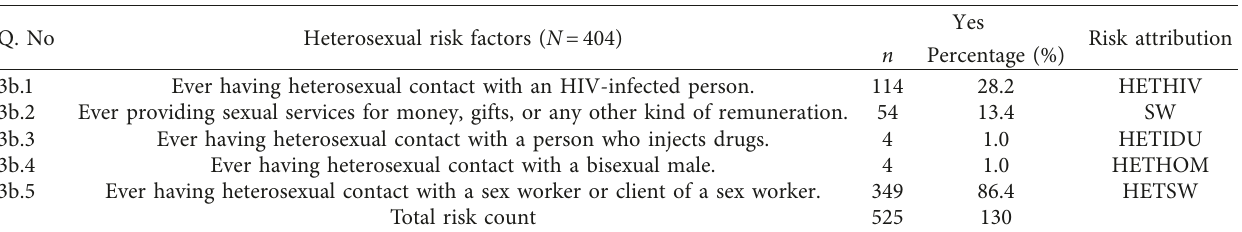
Table 2: Risk attribution based on the heterosexual-related risk behavior of the diagnosed HIV cases from 1993 to 2021, Bhutan. Q.